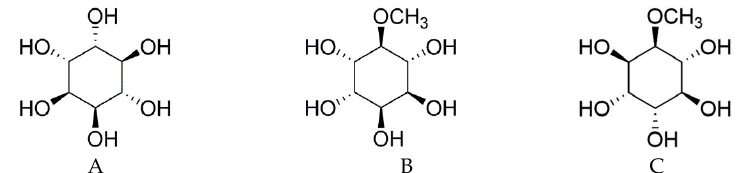
Figure 1. The structures of D -chiro-inositol ( A ), D -pinitol ( B ) and L -quebrachitol ( C ).